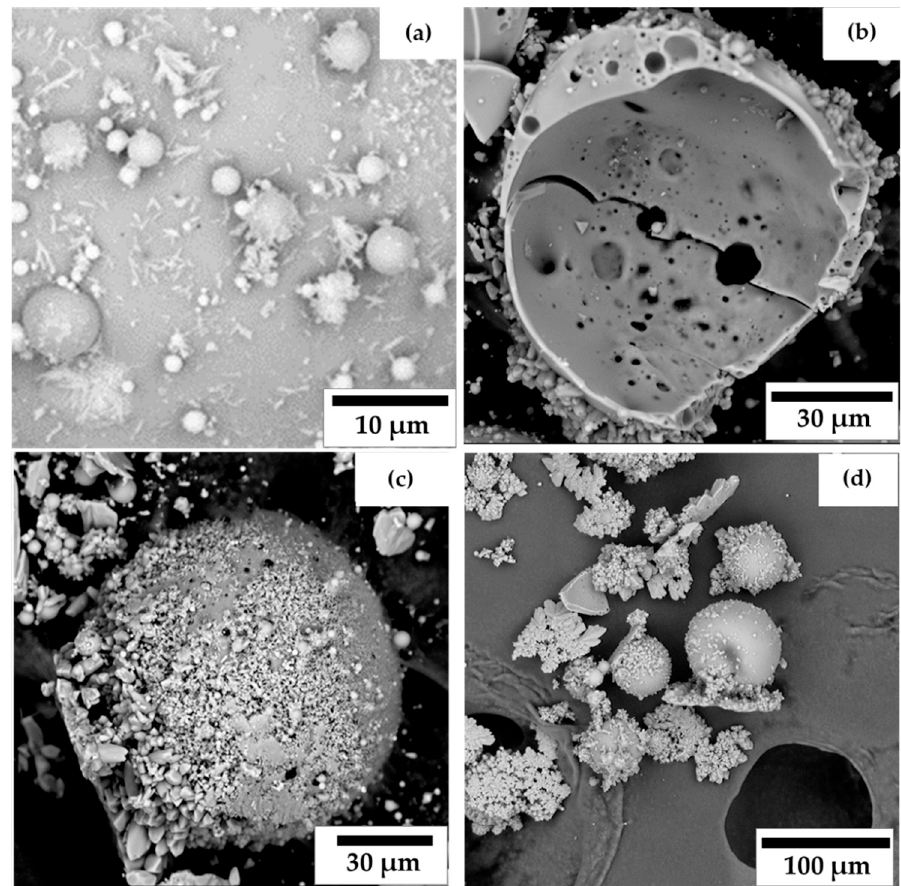
Figure 9. ( a ) The outer surface of cenospheres with different morphologies of aggregates deposited on the surface. ( b ) The broken particle of cenospheres, showing the inner wall surface. ( c , d ) Almost the entire surface of a cenosphere particle covered with a large amount of the aggregates: this particle was collected after a soaking period of 24 h using a 1:5 fly ash/medium ratio and 100% water as a medium.